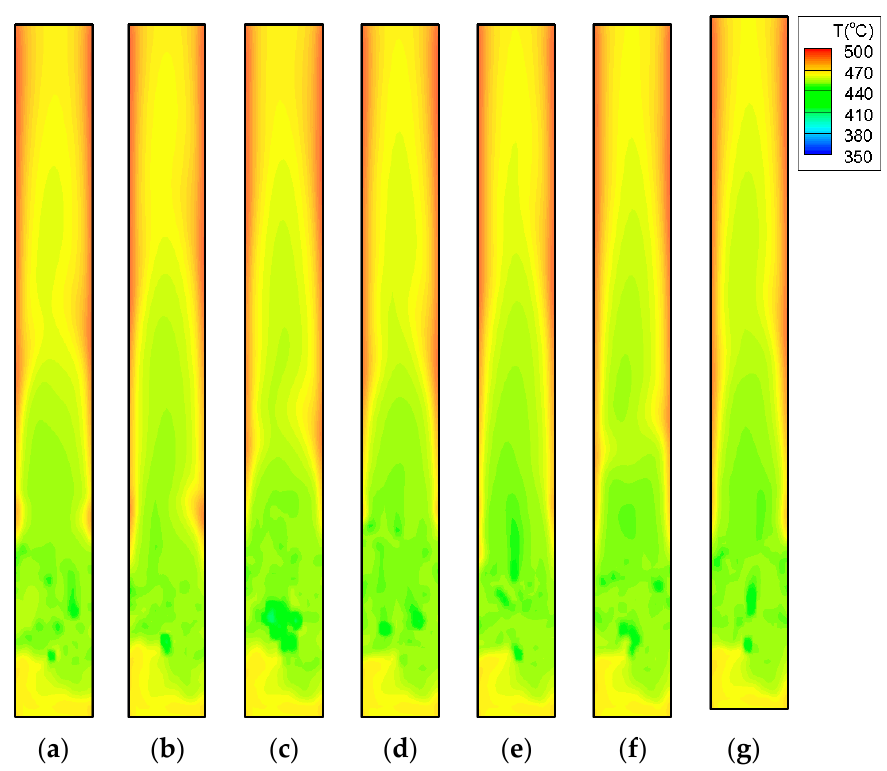
( g ) Figure 6. CO mass fractions. ( a ) 9 s, ( b ) 9.1 s, ( c ) 9.2 s, ( d ) 9.3 s, ( e ) 9.4 s, ( f ) 9.5 s, and ( g ) 9.6 s.